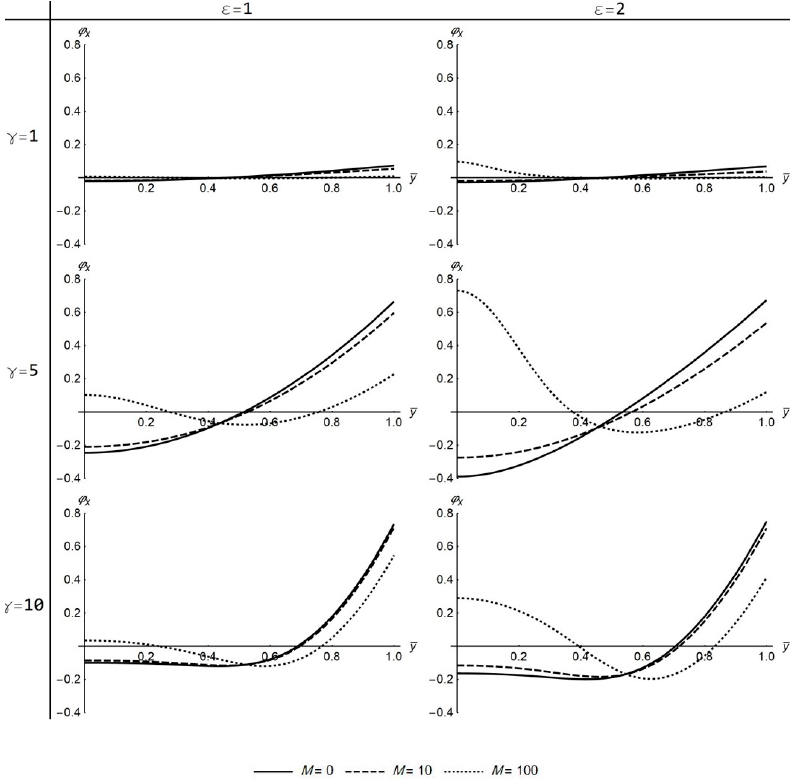
Figure 11. The profiles of 𝜑 (cid:3051) for different values of the 𝜀 , 𝛾,𝑎𝑛𝑑 𝑀 parameters (parallel case).